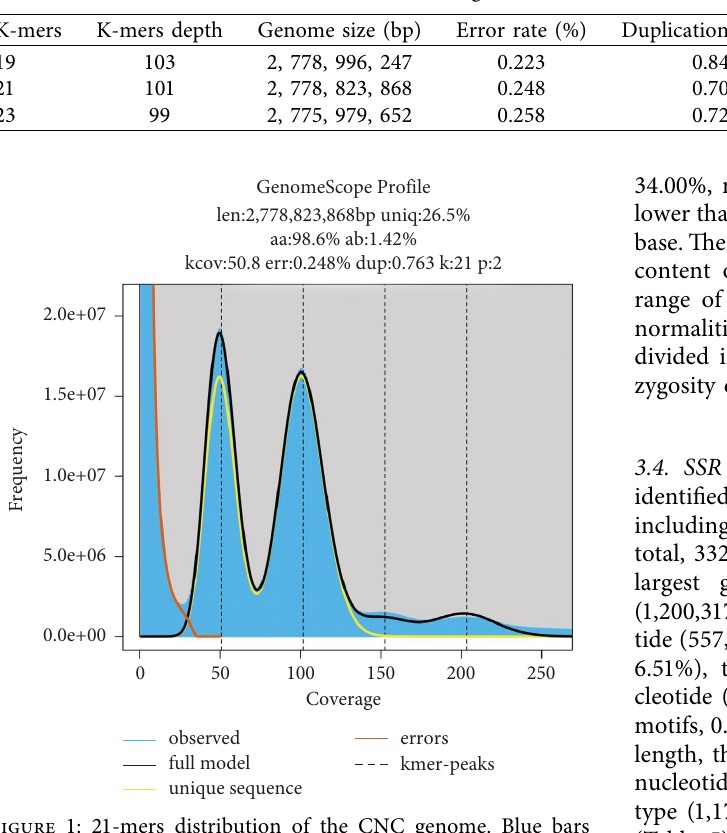
Table 2: CNC genome estimation based on K-mers analysis.